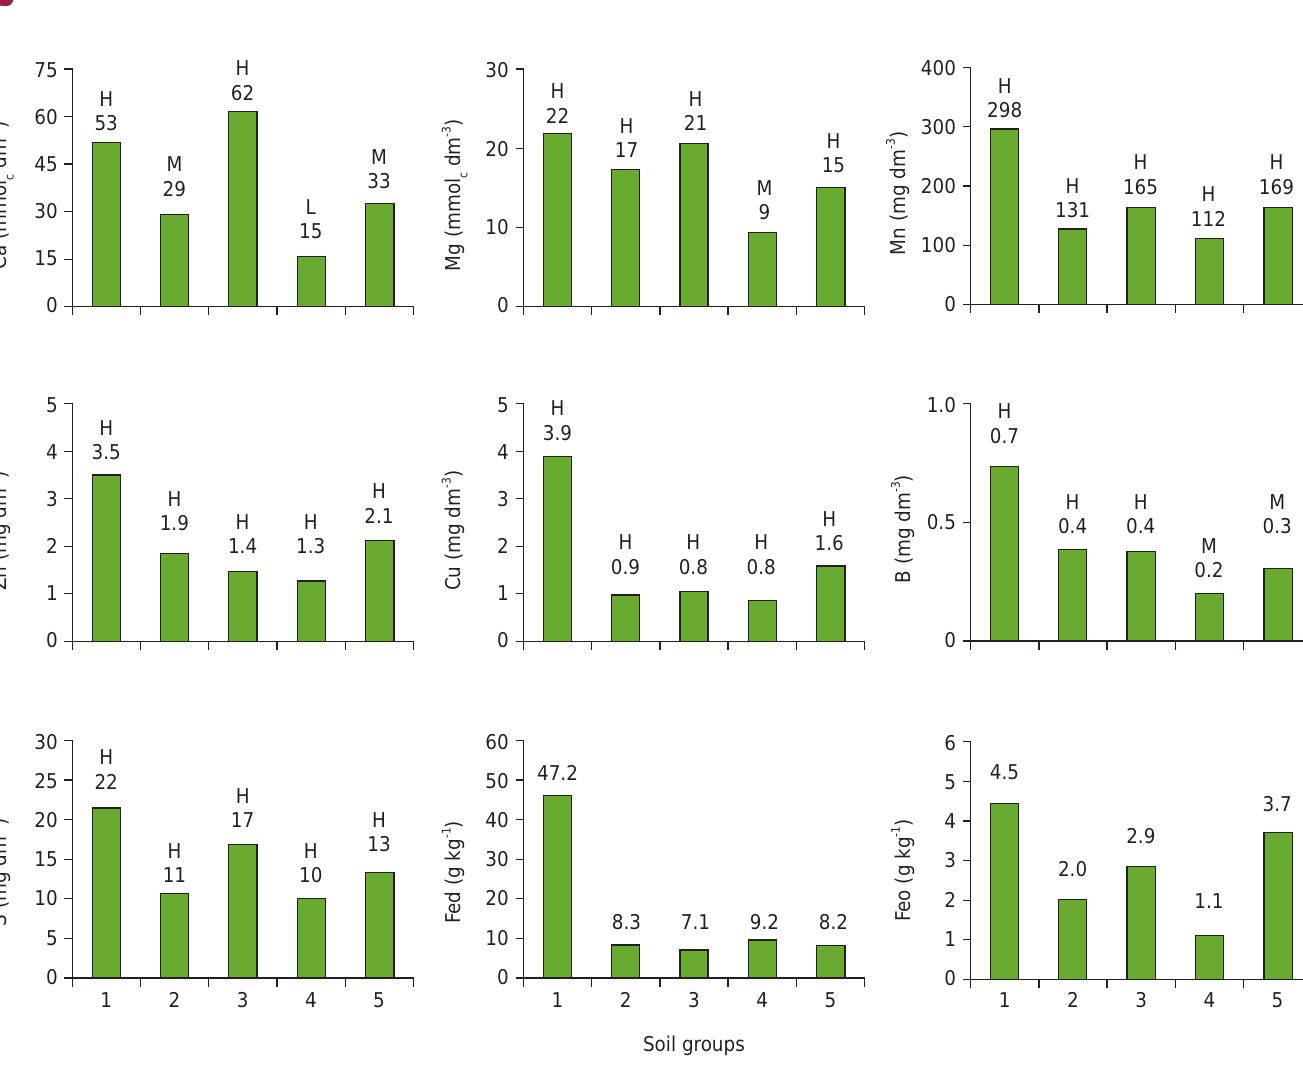
Figure 2. Average contents of exchangeable Ca, Mg, and Mn; extractable Zn, Cu, B, and S; and Fe oxides of high (Fe d ) and low (Fe o ) crystallinity in the soil groups according to table 1. L = low; M = medium; H = high, according to the SBCS/NRS (2004, 2016). Analytical methodology used according to table